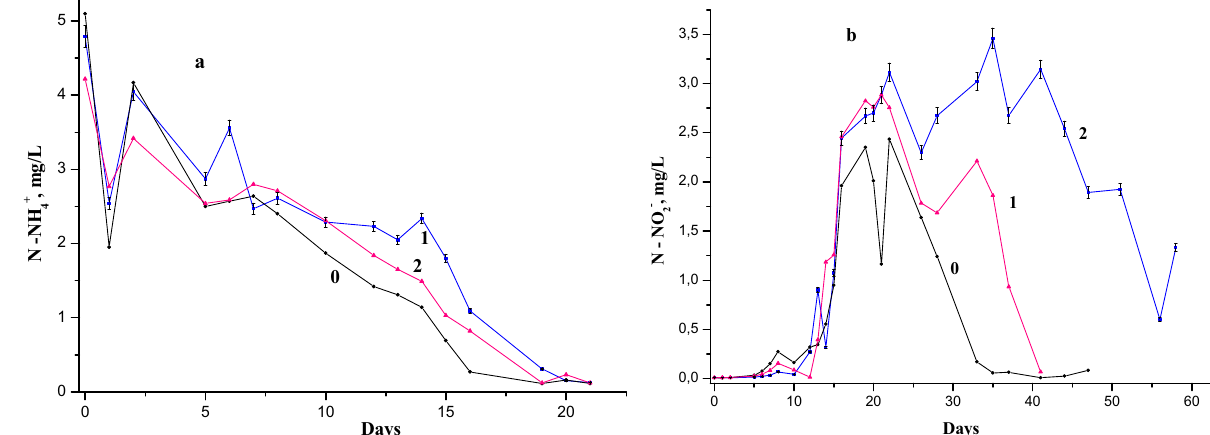
Figure 7. The dynamics of ( a ) ammonium (0- reference sample, 1- with 0.05 mg/L, 2- with 0.5 mg/L of diphenylamine) and ( b ) nitrite ions (0- reference sample, 1- with 0.05 mg/L, 2- with 0.5 mg/L of diphenylamine) in model samples with 6 mg/L NH 4+ in the Nistru River water.